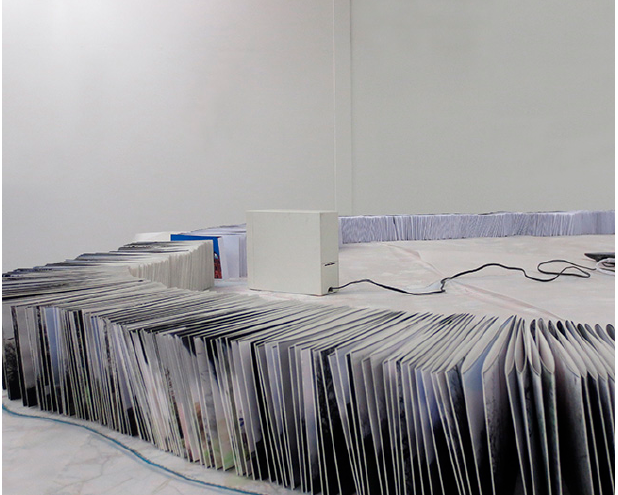
Figure 3. The Author, The M25 in 4000 Images (2014). Inkjet on matte paper, cut, folded, and constructed by hand. Edition of 1. Shown as an installation with constructed map and drawing/planning document and online replay of The Great Orbital Run , with sound (detail). Photo: The